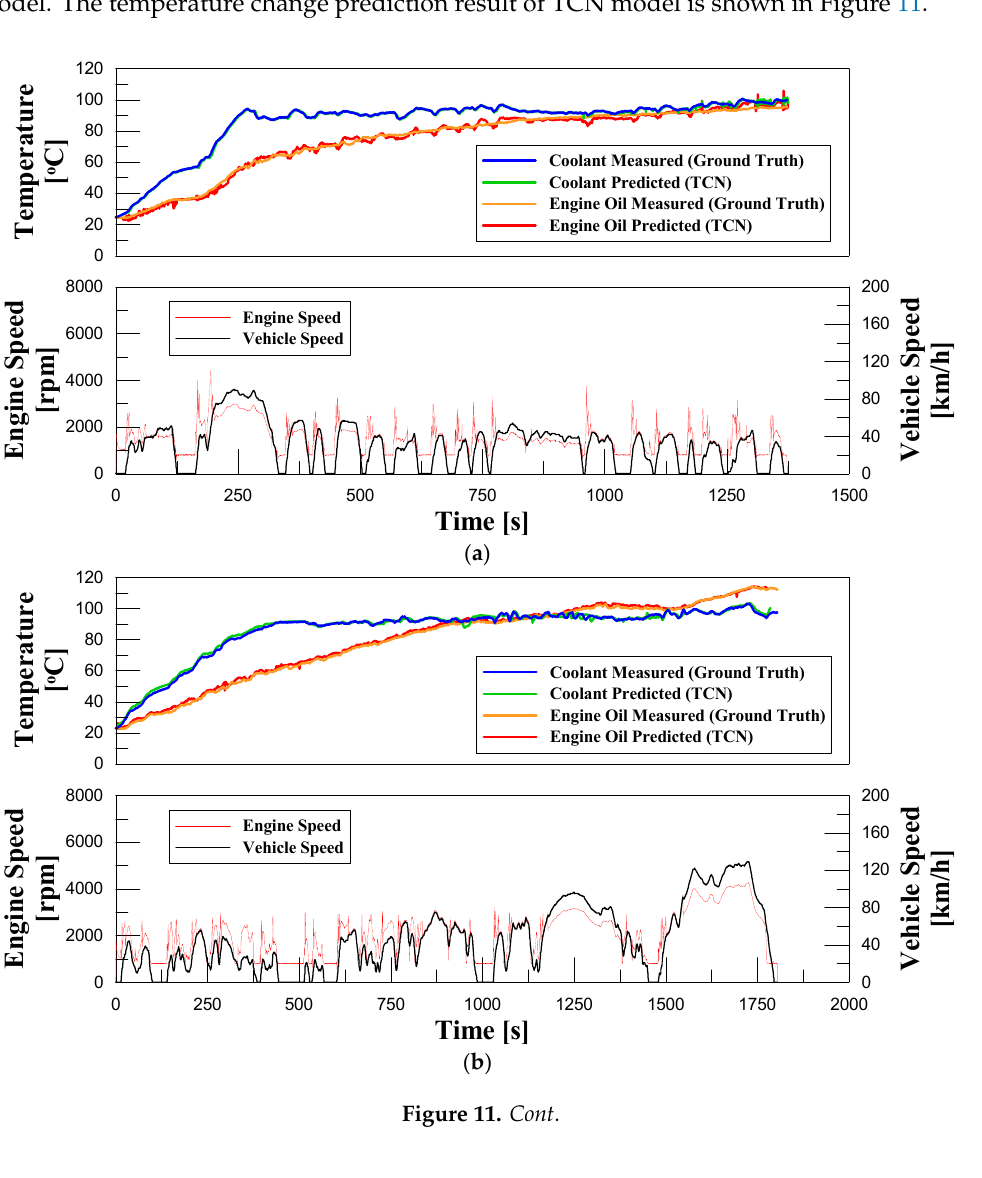
Table 5. Parameter optimization for TCN models.